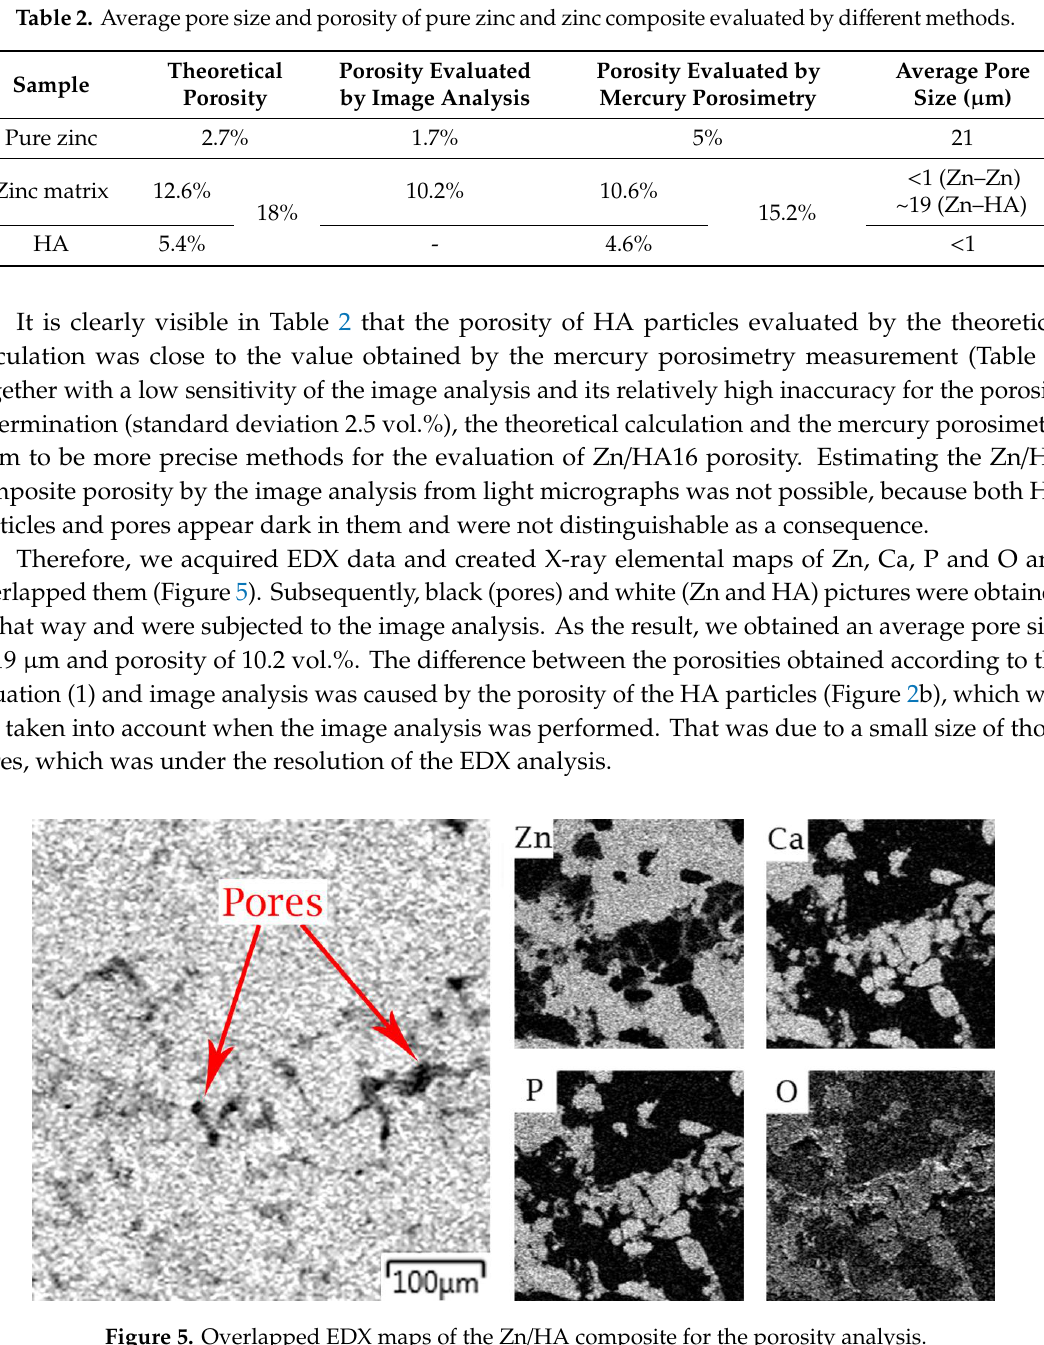
Figure 5. Overlapped EDX maps of the Zn / HA composite for the porosity analysis.